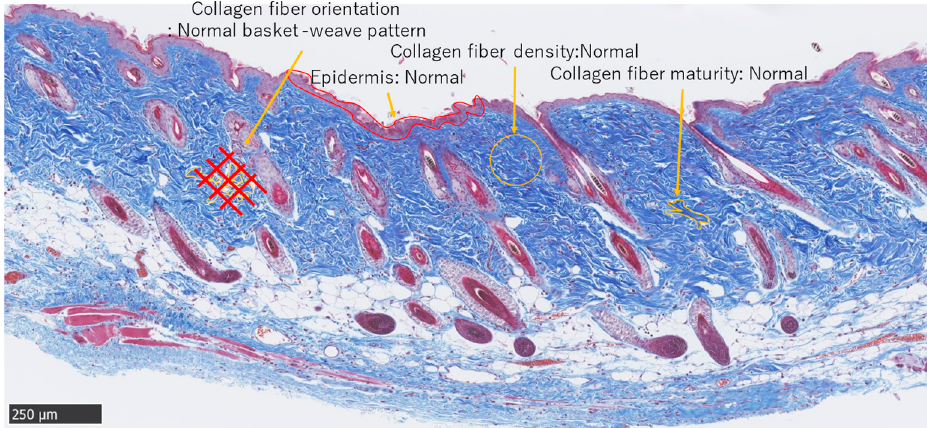
Figure 5. Masson trichrome staining. Normal adult skin (Scale bar 250 µm).